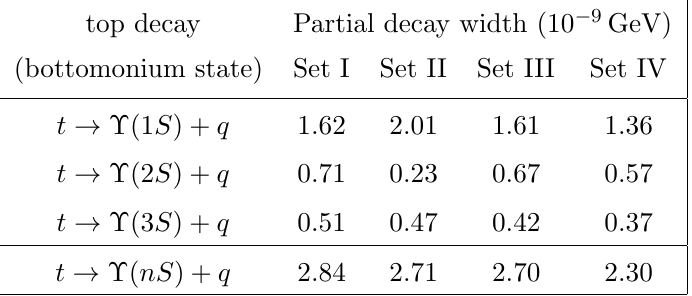
Table 3 . Partial widths (in units of 10 (cid:0) 9 GeV) of inclusive top-quark decays into (cid:7)(1 S; 2 S; 3 S ) mesons (including feed-down contributions from higher-excited bottomonia decays) plus a quark, for the four LDME sets considered in this